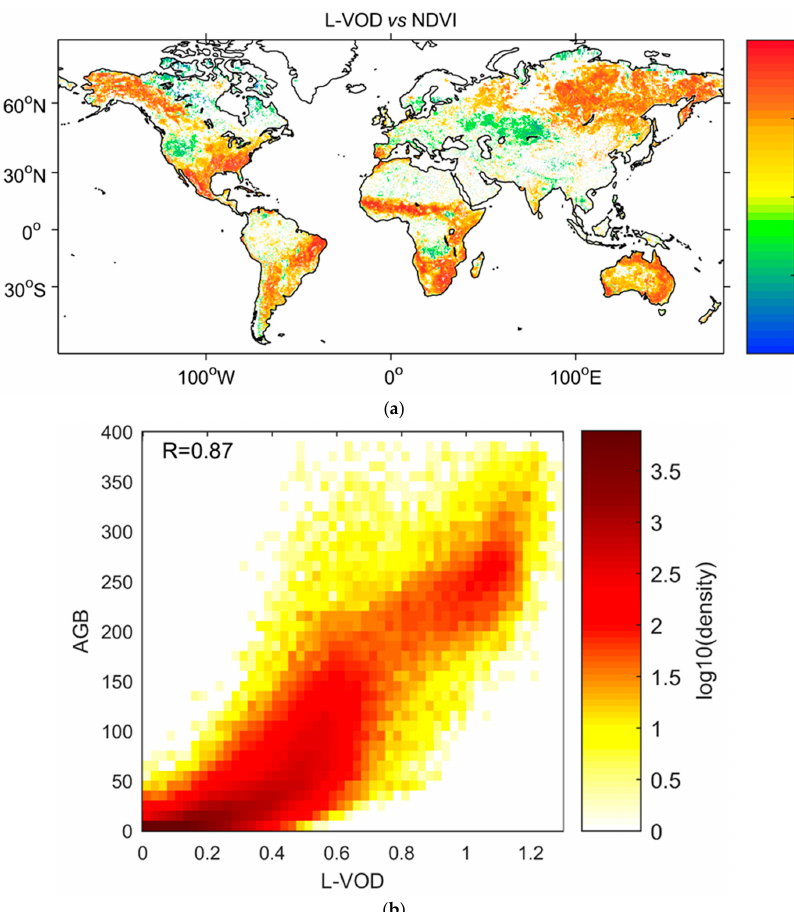
Figure 3. ( a ) Pixel-based temporal correlation (R) for the relationship between 16-day average values of SMOS-IC L-VOD and Moderate Resolution Imaging Spectroradiometer (MODIS) normalized difference vegetation index (NDVI). Grey areas correspond to pixels where correlation is not significant as defined by a p -value > 0.05. White areas indicate “no valid data”; ( b ) Density scatter plots showing the spatial relationship between temporal mean of retrieved SMOS-IC L-VOD with above-ground biomass (AGB) values from [145] at global scale. Adapted from